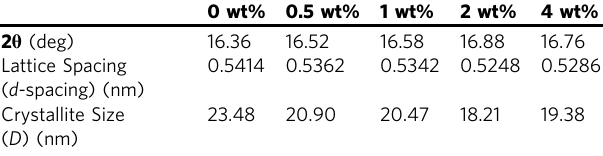
Table 4 The shifts in 2 θ values, lattice spacing ( d -spacing), and crystallite sizes ( D ) were determined by the WAXS analyses of neat DCPD and DCPD/0.5 – 4wt% AC